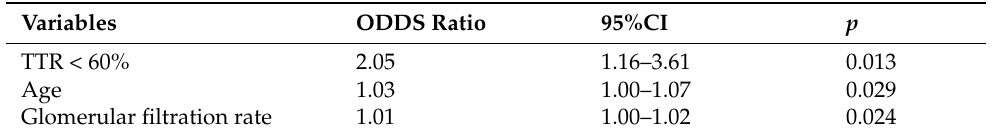
Table 4. Multivariate analysis of factors associated with early rehospitalization in patients with HF and adverse reaction to